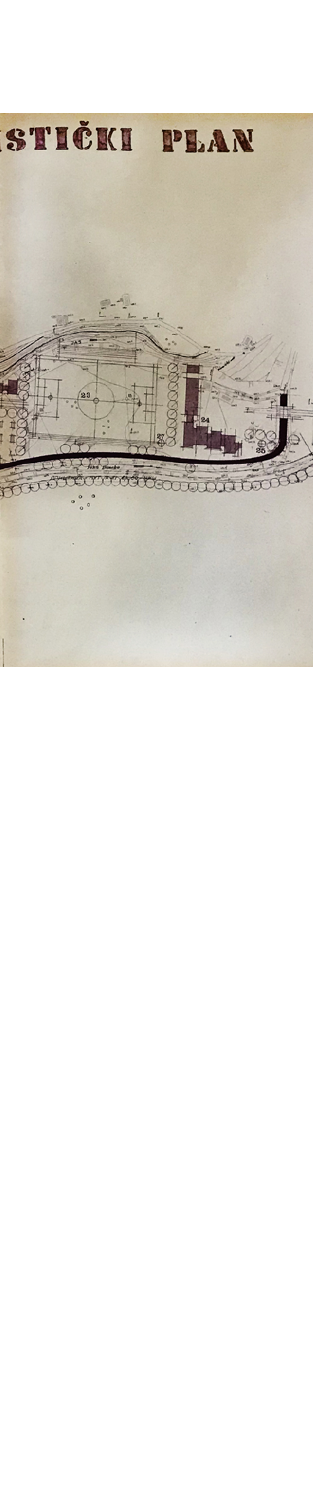
Fig. 5 Franc Avbelj et al., Detailed Urban Plan of Kuršumlija Spa (1973) (Source: Planika Com- pany Archive in